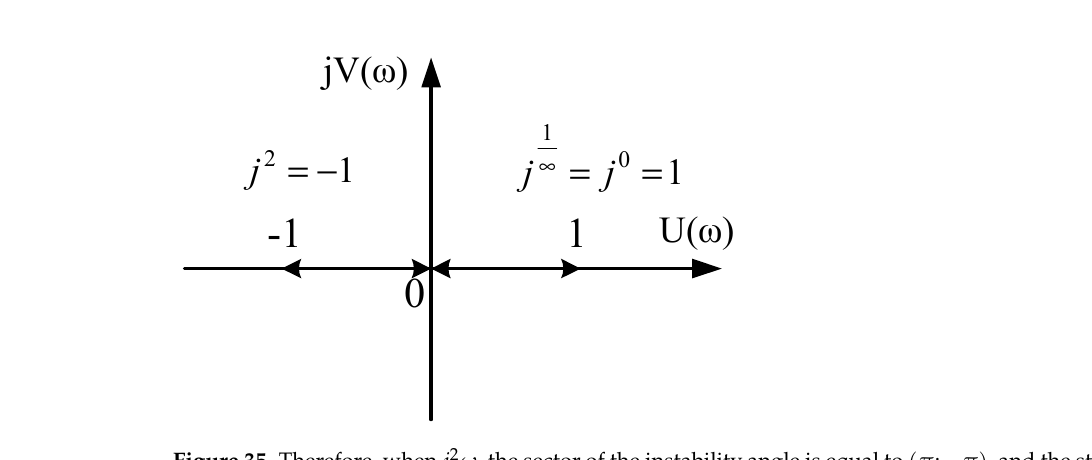
Figure 35. Therefore, when j 2 ω , the sector of the instability angle is equal to ( π ; − π ) , and the stability zone is equal to zero. In the case when j 1 ∞ ω , then the sector of the instability angle is zero.